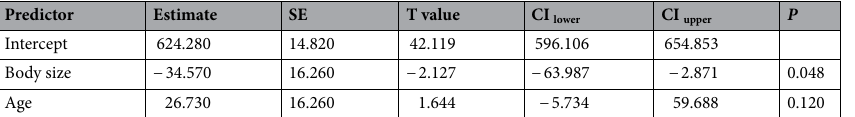
Table 3. The influence of body size (back breadth) and the control variable age on peak frequency of chest beats (Hz; N = 36). Body size and age were z-transformed to a mean of 0 and standard deviation of 1. Full null model comparison: χ 2 1 = 3.919; P = 0.048. CI: upper (97.5%) and lower (2.5%) confidence intervals.